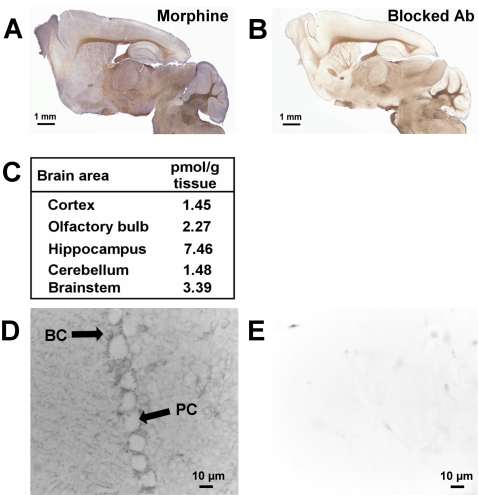
Mapping of endogenous morphine in the mouse brain.
A. Immunodetection of morphine present in the mouse brain. Sagittal slices were incubated with a mouse monoclonal anti-morphine antibody and visualized with an HRP-conjugated donkey anti-mouse IgG, in order to detect endogenous morphine in specific brain areas. B. Control experiment using morphine immunoadsorbed mouse monoclonal antibody (same incubation time as in A). C. Quantification of the morphine present in different mouse brain areas using morphine-specific ELISA. The table shows the quantities of endogenous morphine (pmoles) present per gram of wet tissue. The values correspond to an average of the morphine amount determined for 5 brains (n = 5). D. Localization of morphine label in the cerebellum using mouse monoclonal anti-morphine antibody and an HRP-conjugated secondary antibody. Morphine labelling was observed around Purkinje cells and in basket cells. PC, Purkinje cell; BC, basket cell. E. Control for immunolabelling using morphine-immunoadsorbed mouse monoclonal antibody.